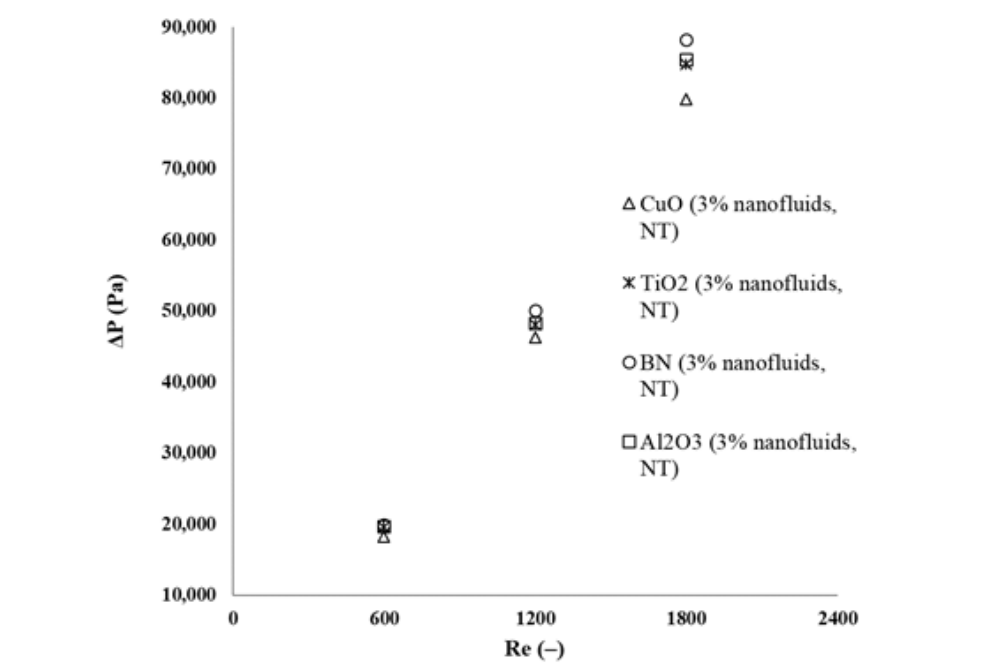
Figure 10. Comparison of the pressure drop values for different Reynolds numbers obtained using numerical tests (NT).